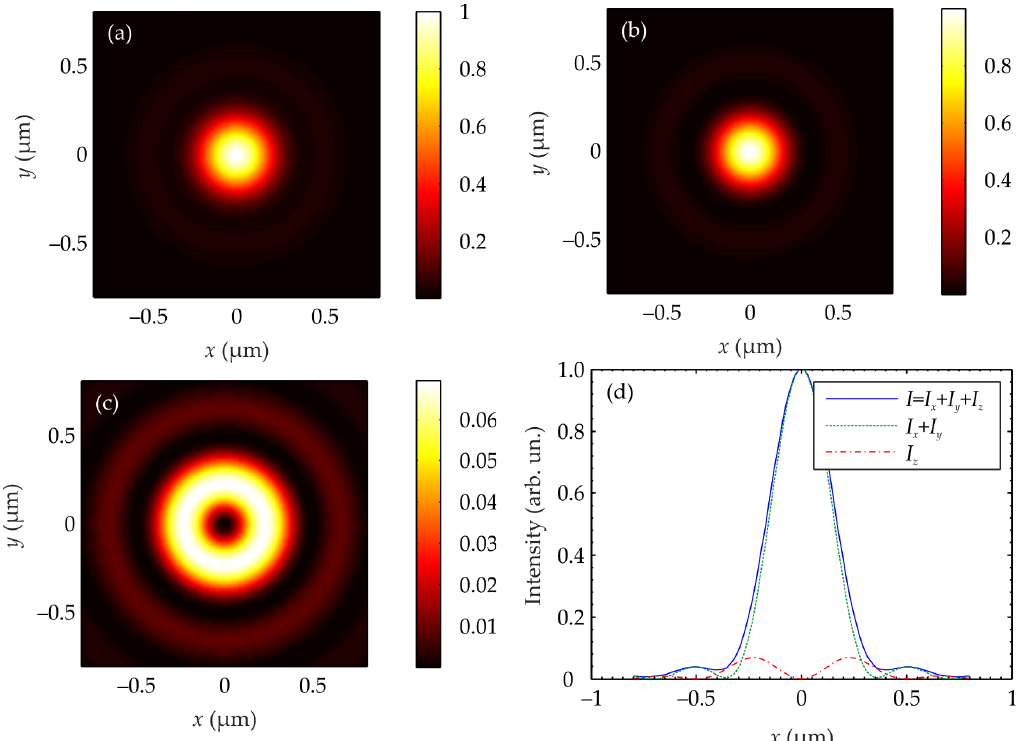
Figure 3. Distributions of intensity at the focus ( a ) and intensity components I r ( b ) and I z ( c ) when focusing light with a flat diffractive lens with NA = 0.8. The intensity profile along the x ‐ axis ( d ).